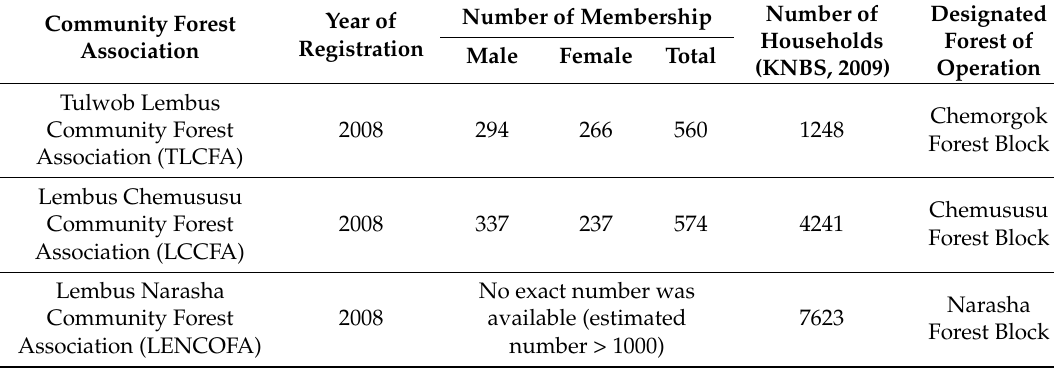
Table 9. Registered community forest associations (CFAs) operating in the Lembus Forest blocks.